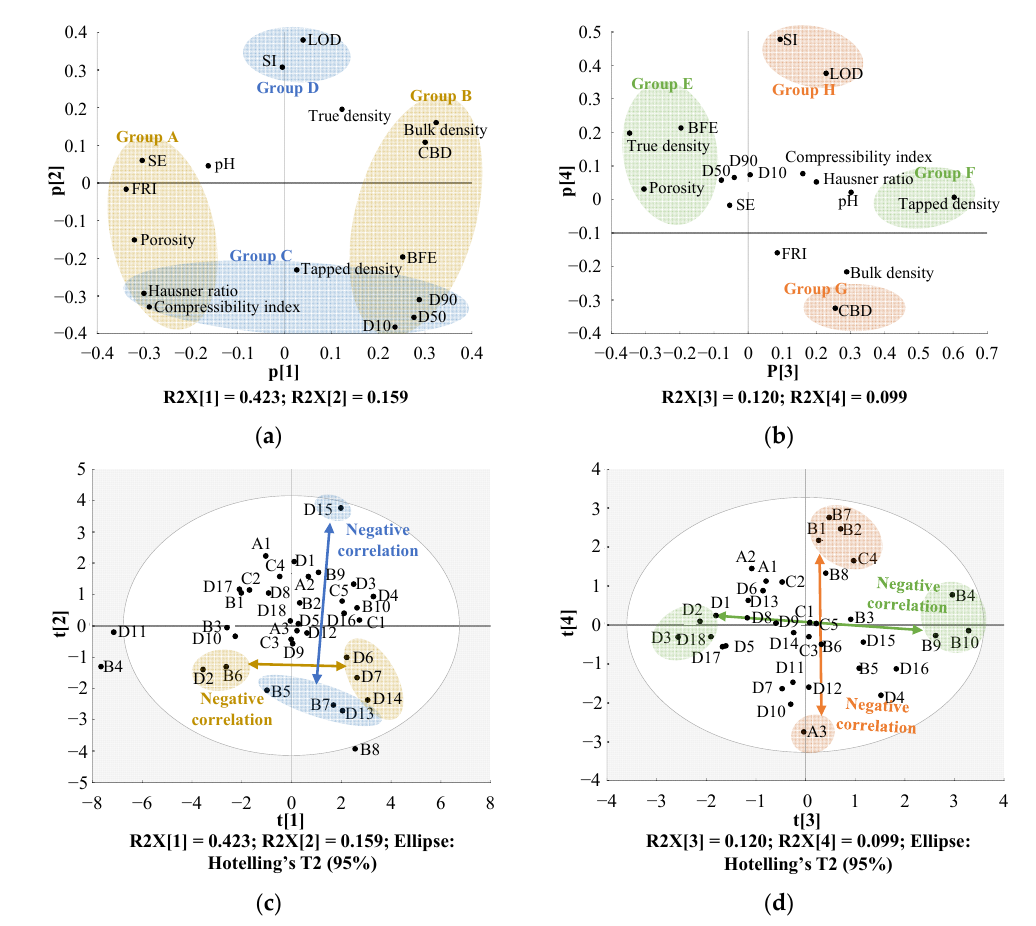
Figure 2. Result of principal component analysis; ( a ) Loading plot with PC1 and PC2; ( b ) Loading plot with PC3 and PC4; ( c ) Score plot with PC1 and PC2; ( d ) Score plot with PC3 and PC4. The yellow area indicates physicochemical properties significantly affecting PC1, the blue area denotes the physicochemical properties significantly affecting PC2, the light green area indicates the physicochemical properties significantly affecting PC3, and the orange area indicates the physicochemical properties significantly affecting PC4. (PC, principal component; LOD, loss on drying; BFE, basic flowability energy; SI, stability index; FRI, flow rate index; SE, specific energy; CBD, conditioned bulk density.)